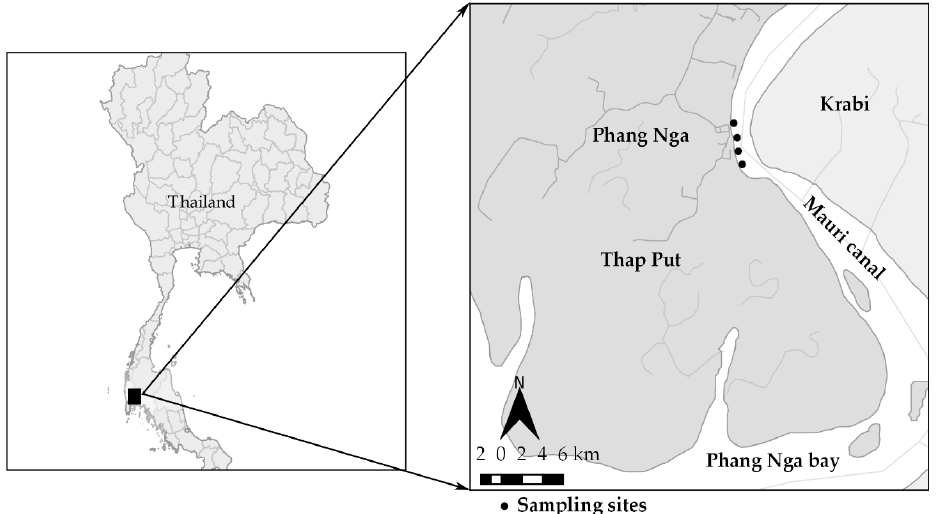
Figure 1. Four sampling sites are indicated as black circle dots, where pooled oyster and estuarine water samples were collected from Marui cannal in Phang Nga bay from southern Thailand. Source: Map of Thailand (www.diva-gis.org/gdata).